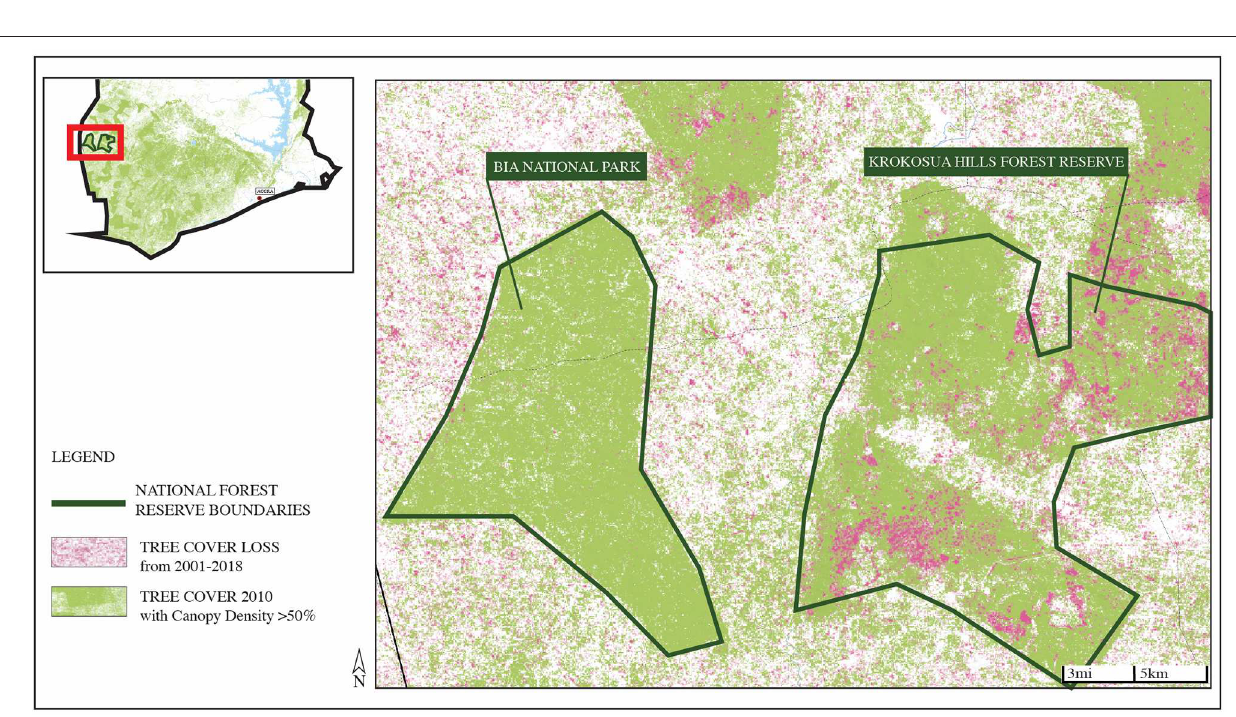
Frontiers in Sustainable Food Systems | www.frontiersin.org